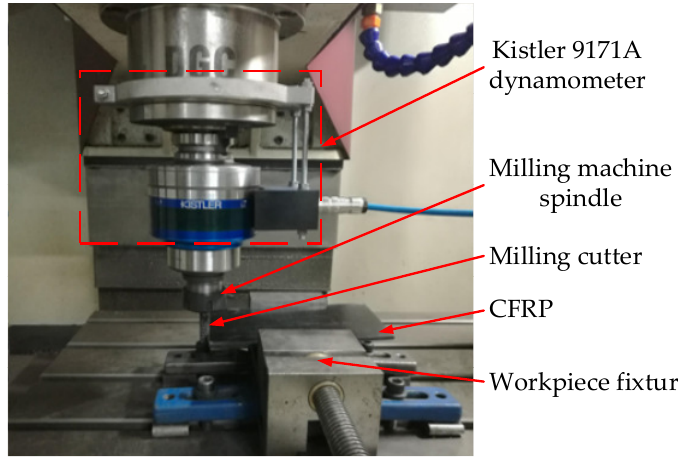
Figure 1. The test site layout.